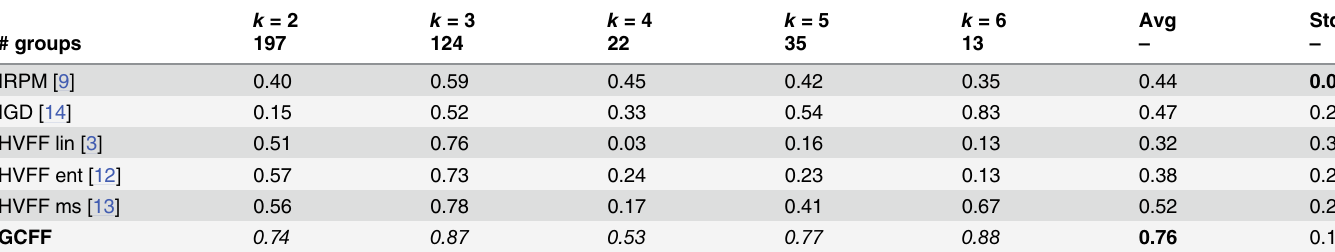
Table 8. GDet – F 1 score VS . cardinality. ( T = 1).